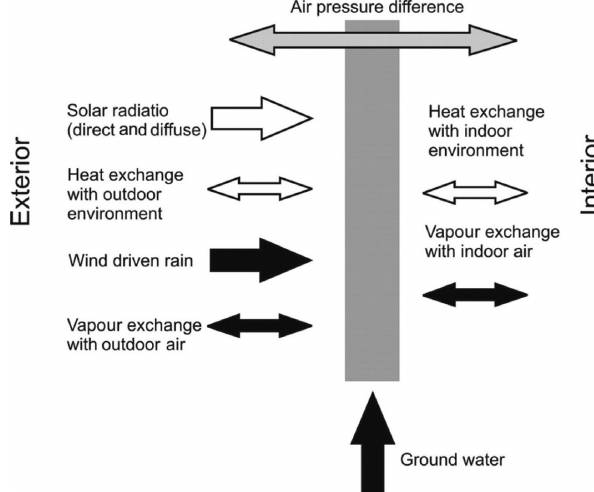
Schematic representation of the moisture loads acting on the building envelope caused by dynamic hygrothermal parameters and their alternating diurnal or seasonal directions according to the ASHRAE Handbook of Fundamentals